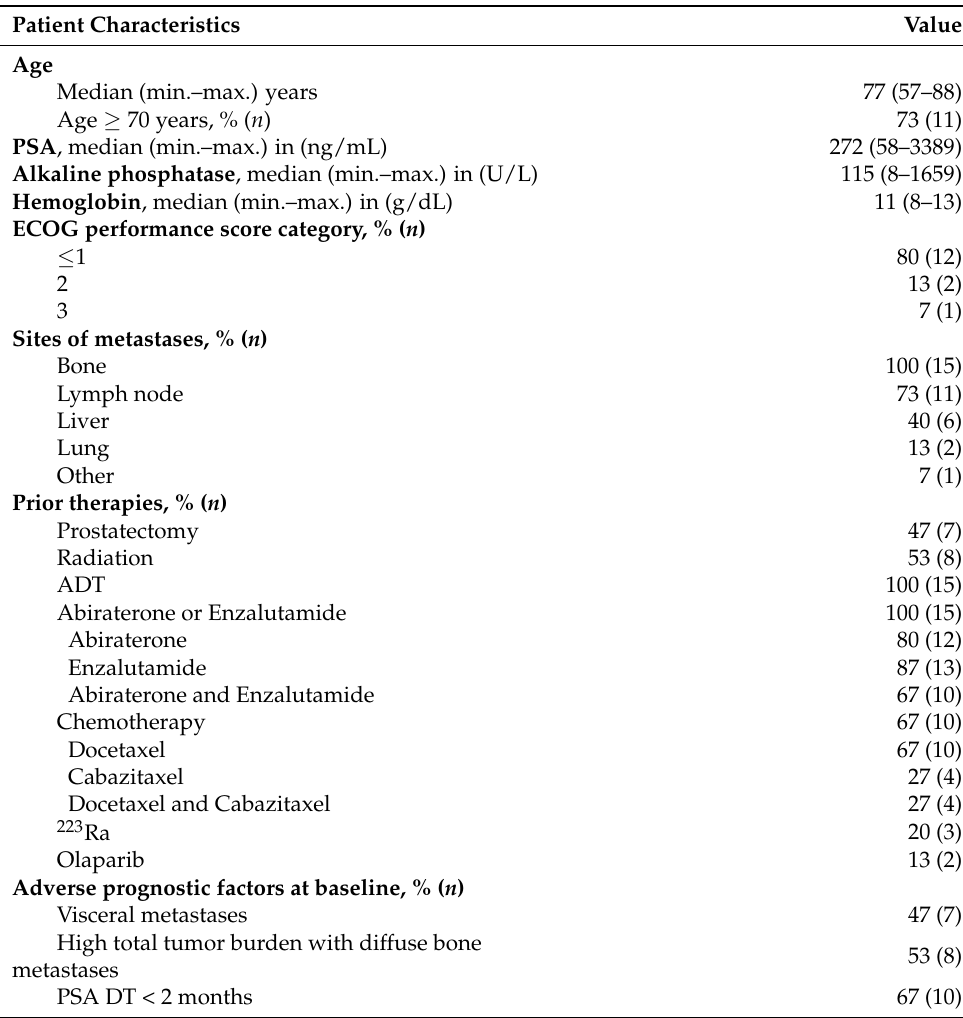
Table 1. Patient